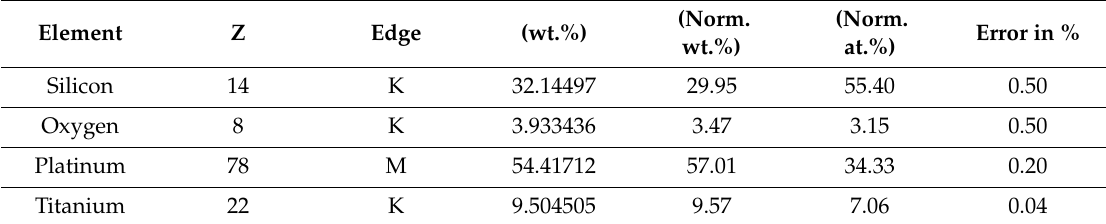
Table 2. EDS elemental analysis for PtTi thin film deposited on a glass substrate.